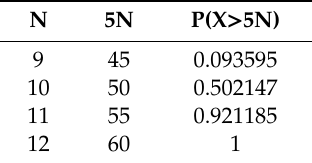
Table 5. Number of customers = 50N (k =